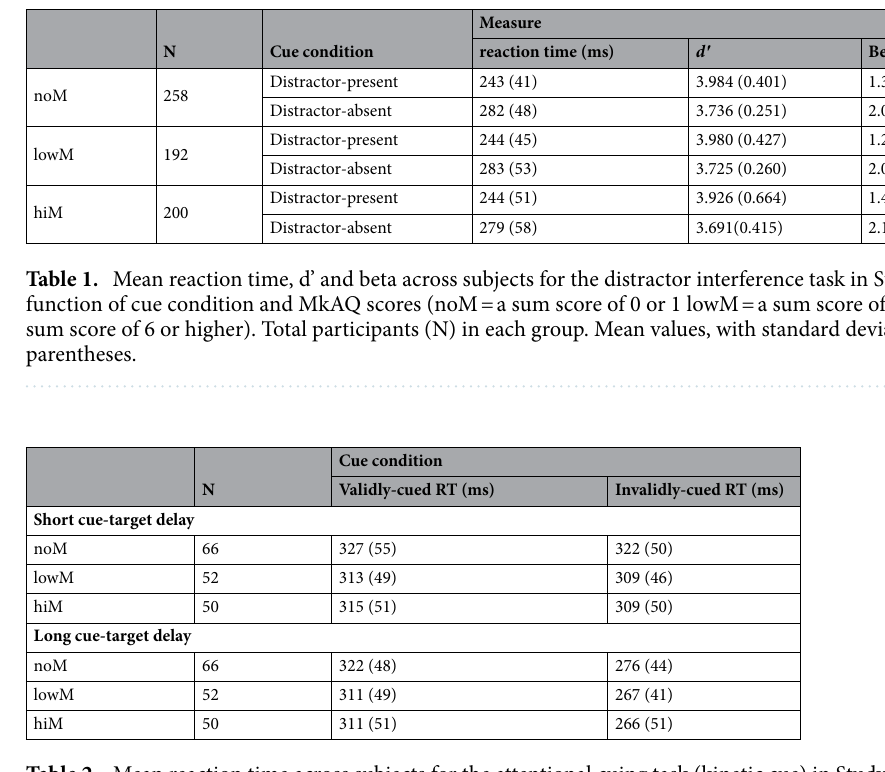
Table 2. Mean reaction time across subjects for the attentional cuing task (kinetic cue) in Study 1, as a function of cue condition, cue-target delay, and MkAQ scores (noM = a sum score of 0 or 1 lowM = a sum score of 2–5, hiM = a sum score of 6 or higher). Total participants (N) in each group. Mean values, with standard deviations in parentheses.